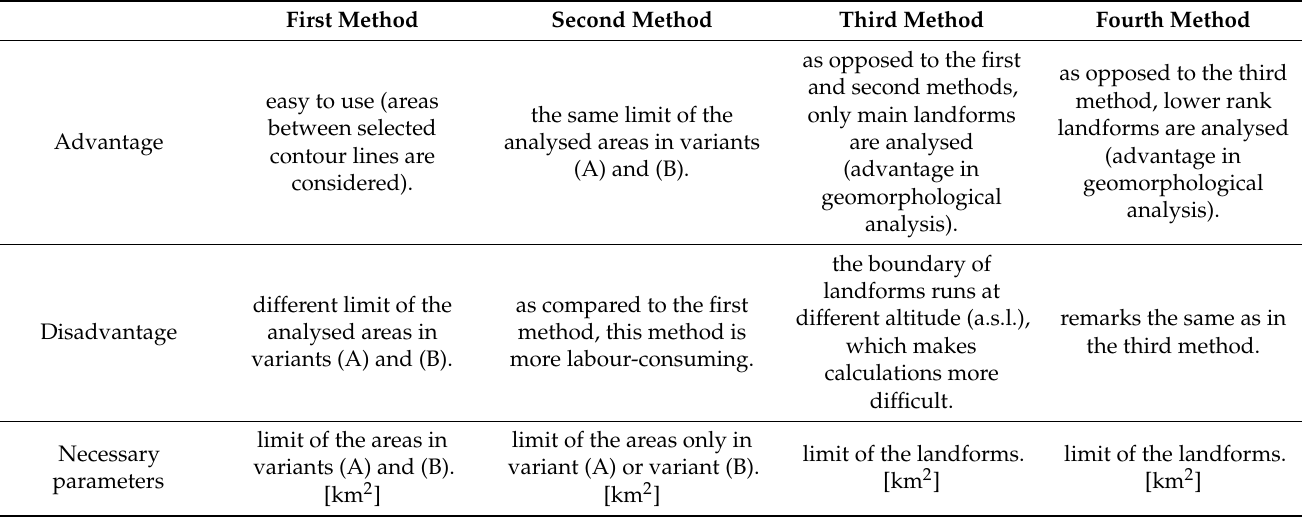
Table 5. Comparison of analytical methods used in the